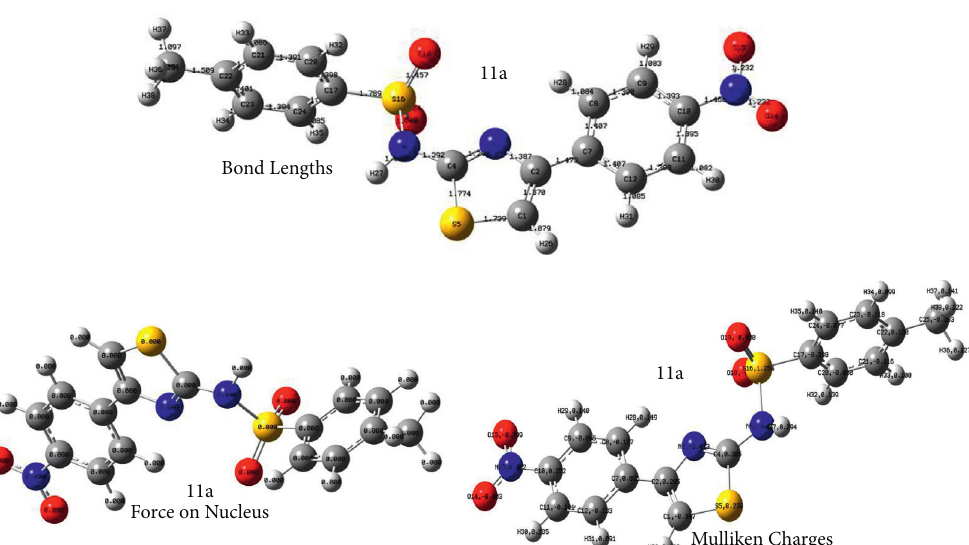
Figure 7: Optimized structures of compound 11a showing bond lengths, force on nucleus, and Mulliken charges.